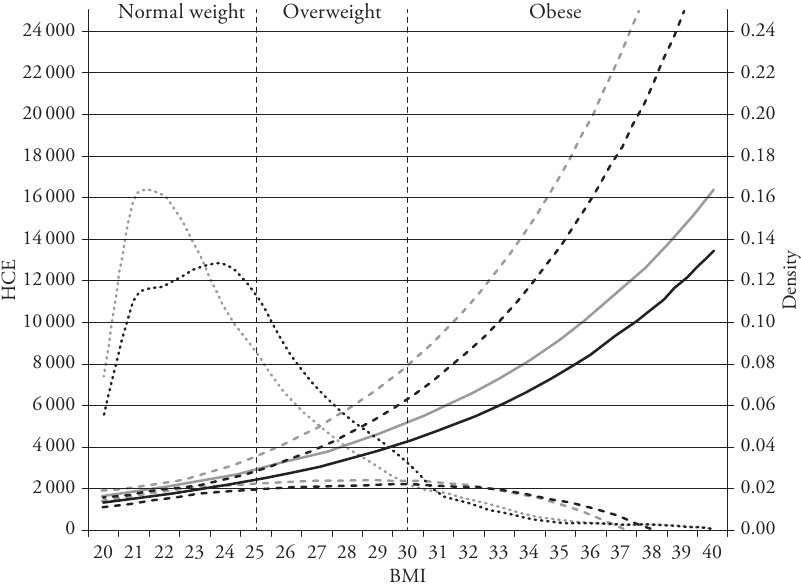
Note: The figure depicts the estimates from the CF model; the black (grey) solid line indicates predicted HCE for men (women); the respective 90% confidence intervals are represented by the dashed lines; dotted lines denote the distribution of BMI in the